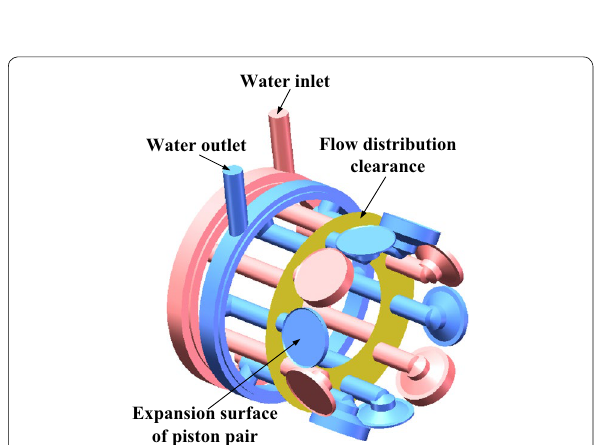
Figure 9 Internal flow channel of seawater hydraulic